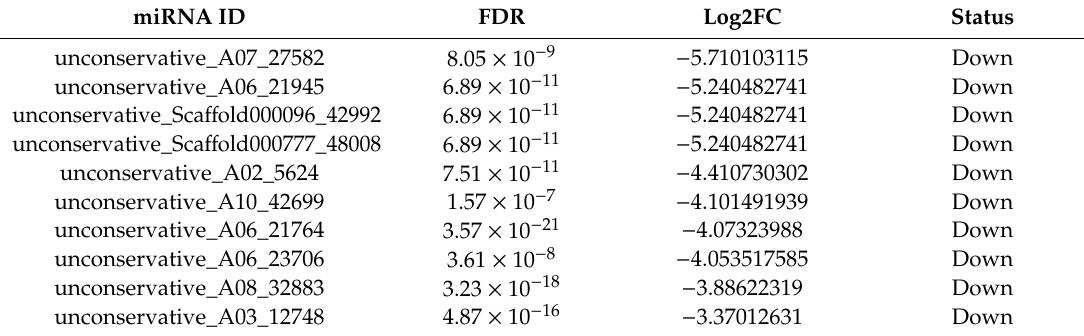
Table 2. Top 10 di ff erentially expressed miRNAs in Bcpol97-05A (sterile line) compared to Bcajh97-01B (fertile line) of Brassica